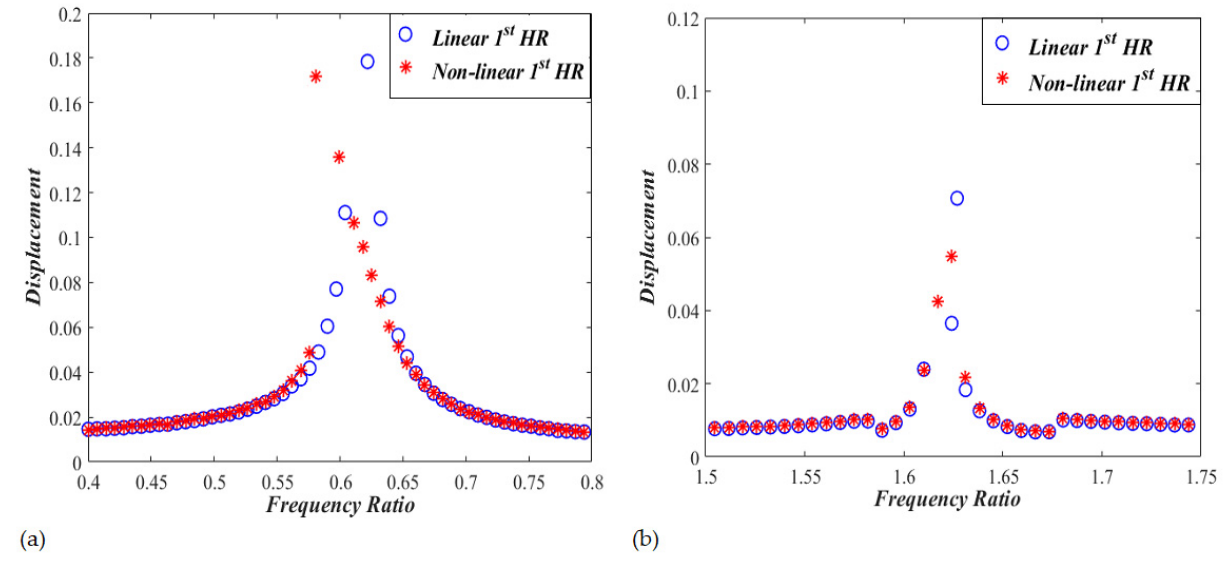
Figure 5. Frequency response curves for linear and non-linear nonlinear dual HRs (CASE I). ( a ) first resonant response, and ( b ) second resonant response.